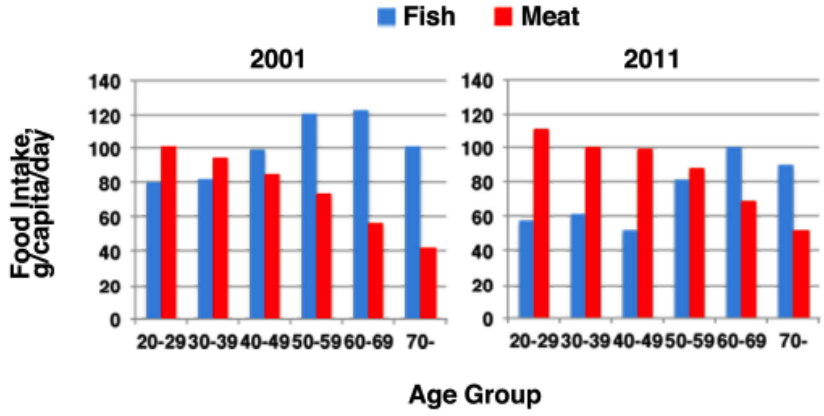
Figure 8. Source of food intake by the age groups of Japanese, according to the National Health and Nutrition Survey